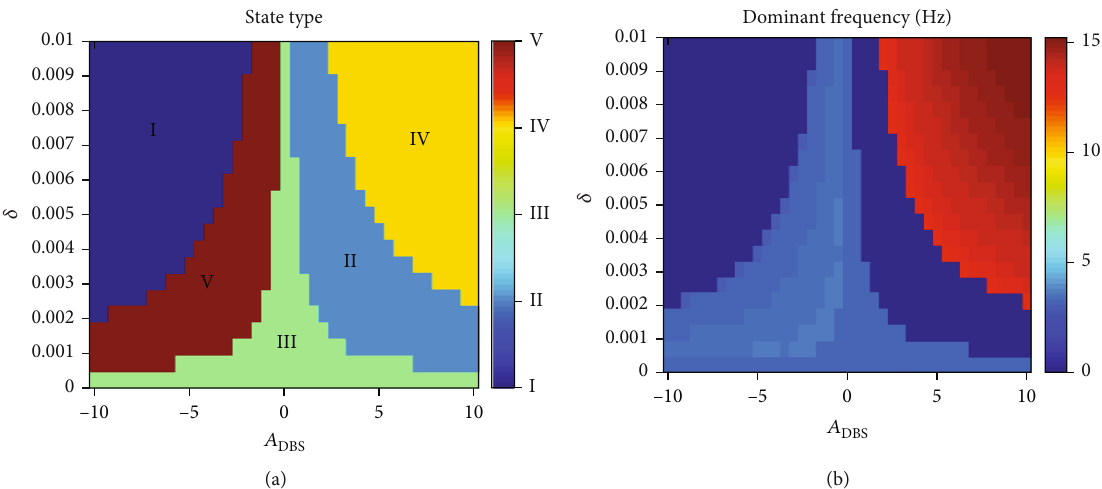
Figure 10: The state types (a) and dominant frequencies (b) after DBS acting on RE at t = 10 s when the system is in SWD originally. I (high saturated state), II (low saturated state), III (SWD), IV (tonic), and V (low-frequency clonic) can be observed. The dominant frequencies of states I and II are 0Hz and of state III and V are between 2 Hz and 4Hz, while the dominant frequencies of state IV are between 13Hz and 15Hz.